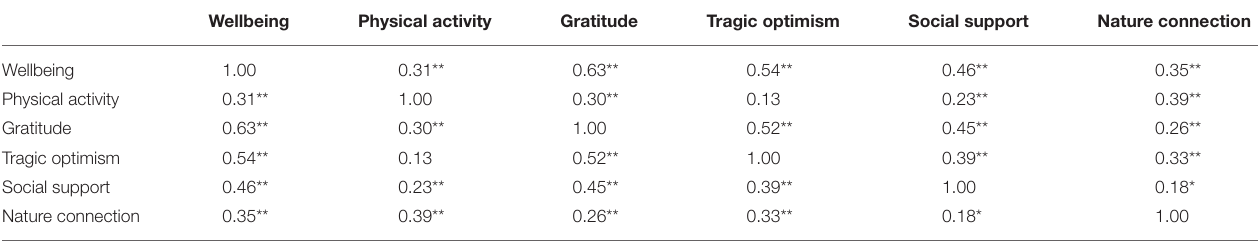
TABLE 3 | Zero-order correlations amongst wellbeing variables.